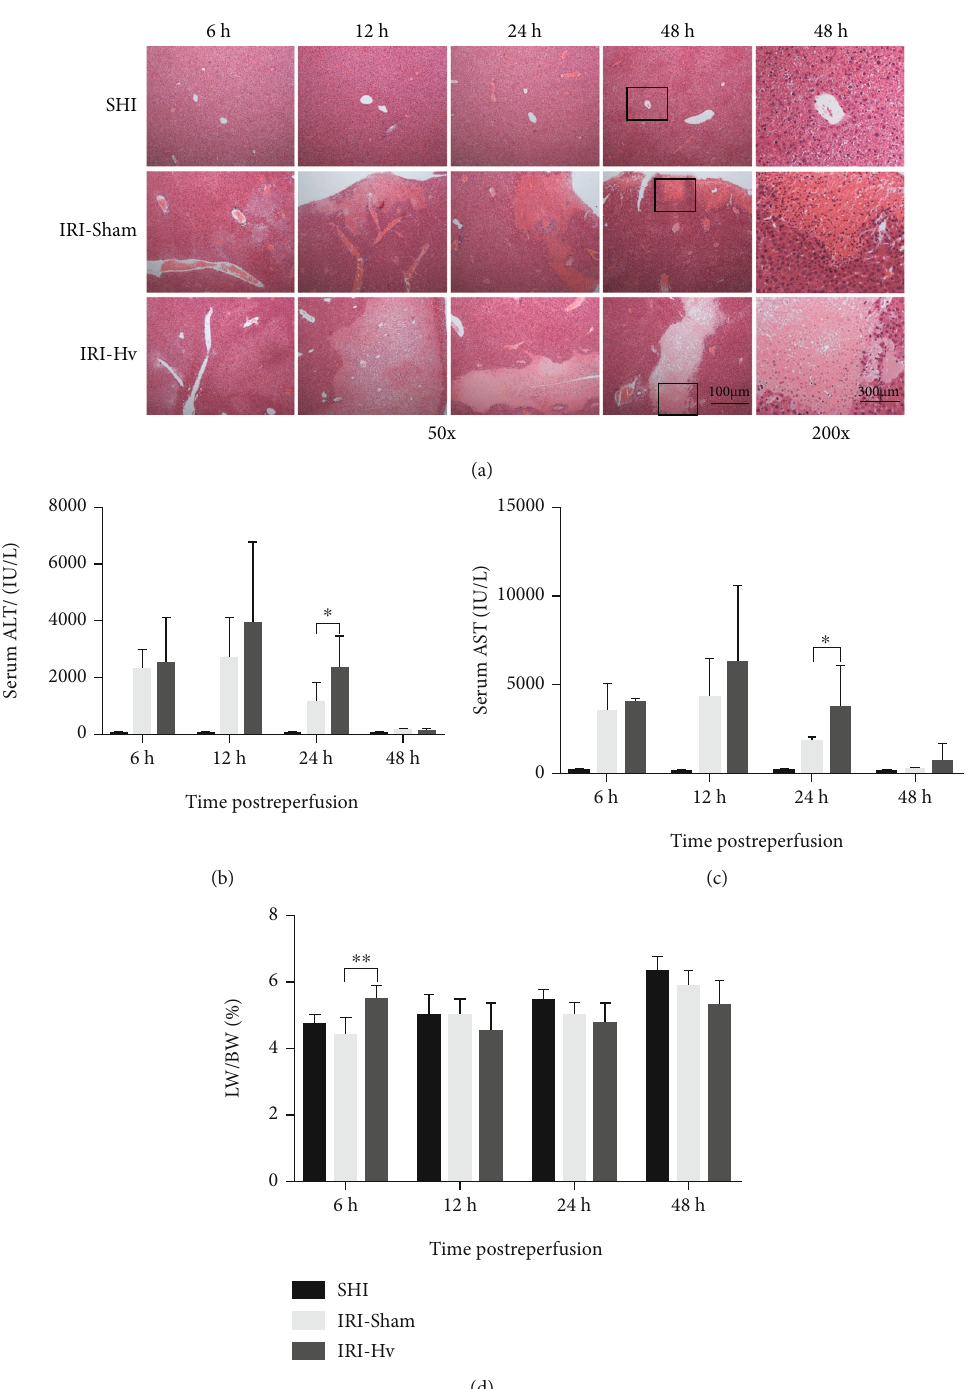
Figure 2: Hepatic vagotomy aggravates hepatic ischemia-reperfusion injury. (a) Representative H&E staining shows ischemic necrosis areas of liver tissues in the three groups at di ff erent time points (6 h, 12 h, 24 h, and 48 h) postreperfusion. Serum samples from di ff erent groups of mice were collected for ALT (b) and AST (c) activity detection. (d) LW/BW (liver weight/body weight) ratios of the three groups at di ff erent time points after reperfusion ( n = 5 ‐ 7 ; ∗ p < 0 : 05 and ∗∗ p < 0 : 01